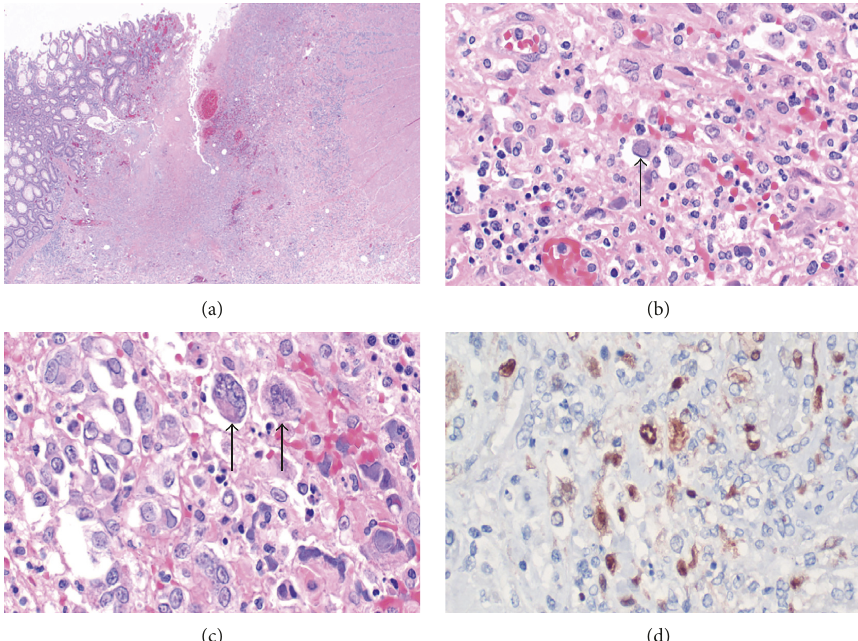
Figure 1: (a) Section from the ulcerated colonic mucosa with deep fissuring ulcer. Viral cytopathic changes are noted. (b, c) Giant cells within ulcer with characteristic intranuclear Cowdry type A inclusions of HSV-1 and HSV-2. Black arrows point to individual giant cells with Cowdry type A inclusions. (d) Immunohistochemistry study for HSV-2 antibody highlighted by the brown nuclear